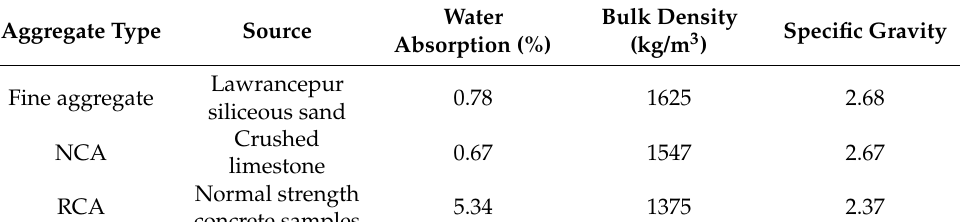
Figure 2. Physical overview of RCA.